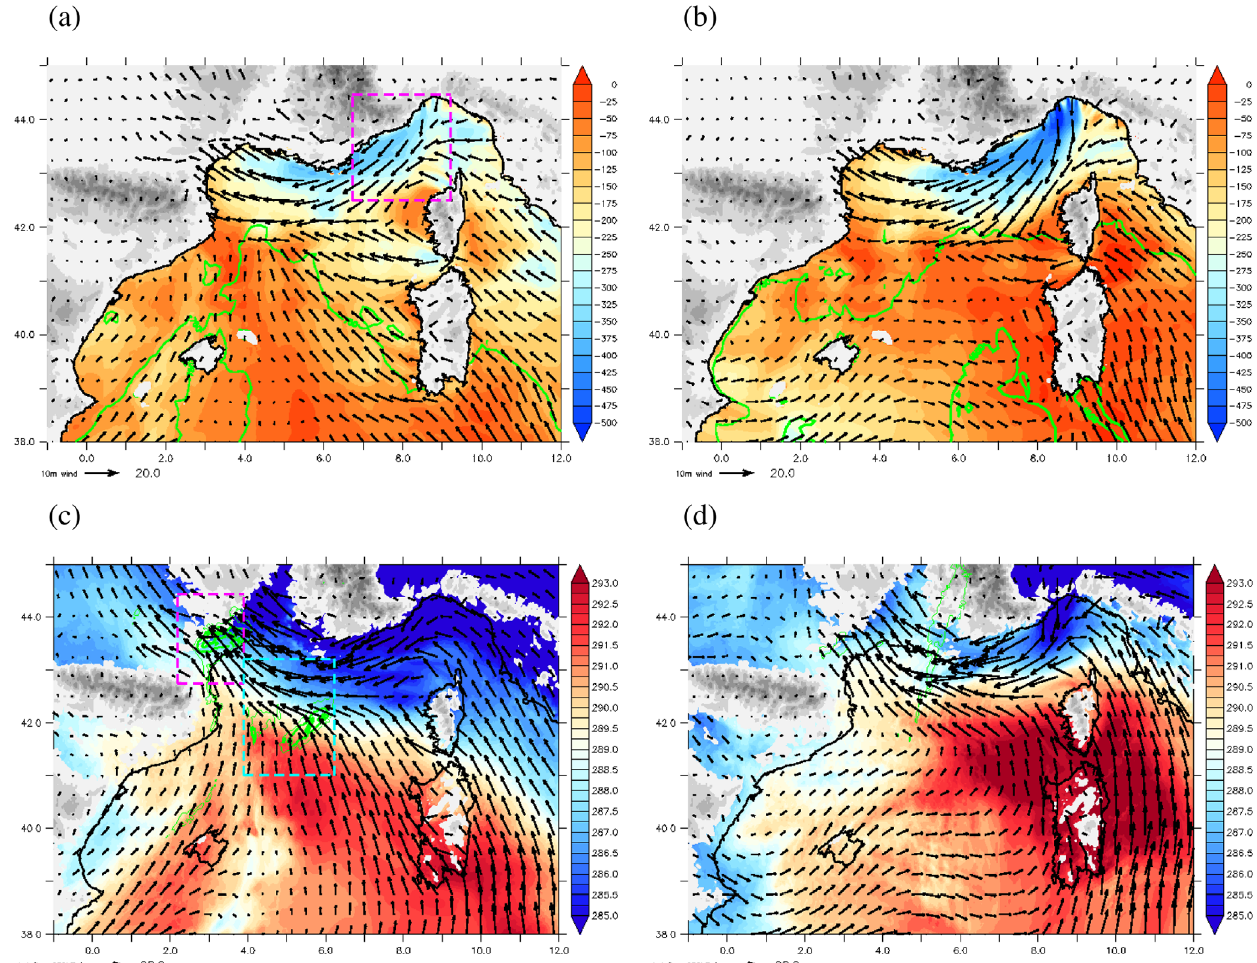
Figure 2. Mean surface and atmospheric low-level conditions: (a, b) enthalpy flux over the sea ( H + LE, colors, Wm − 2 ), convective available potential energy (CAPE, green contours every 750Jkg − 1 ) and 10m wind (arrows, ms − 1 ) and (c, d) θ w ’ (colors, K) and wind (arrows, ms − 1 ) at 925hPa and total rainfall amounts (green contours every 50mm) from the AW forecast during (a, c) the initiation phase (Phase I, between 13 October 2016 03:00UTC and 18:00UTC) and (b, d) the mature phase (Phase II, between 13 October 2016 19:00UTC and 14 October 2016 03:00UTC). See text and Sauvage et al. (2020) for more details. The dashed purple box in (a) indicates the Azur zone. The dashed boxes in (c) indicate the Hérault (purple) and offshore (cyan) areas for precipitation